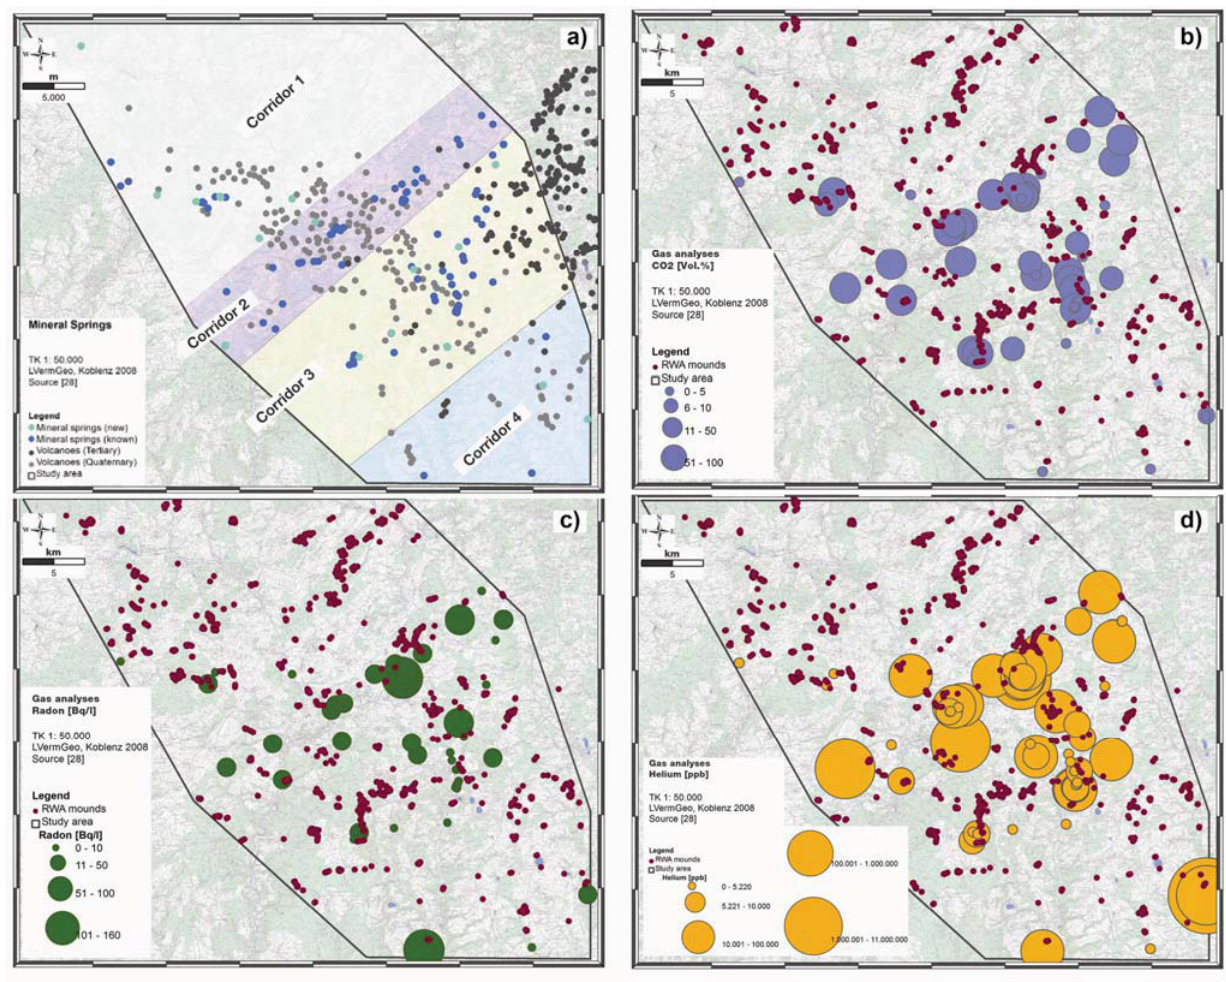
Figure 8. West Eifel study area: Spatial distribution pattern of known (dark blue dots) and new minerals (light blue dots) springs within the Quaternary volcanic field ( a ) as well as CO (blue dots) ( b ), Radon (green dots) ( c ) and Helium (orange dots) concentrations ( d ) in 2 mineral springs and spatial distribution of RWA mounds (dark red dots; (b), (c), (d) [28]). Increasing gas concentrations are shown by increasing